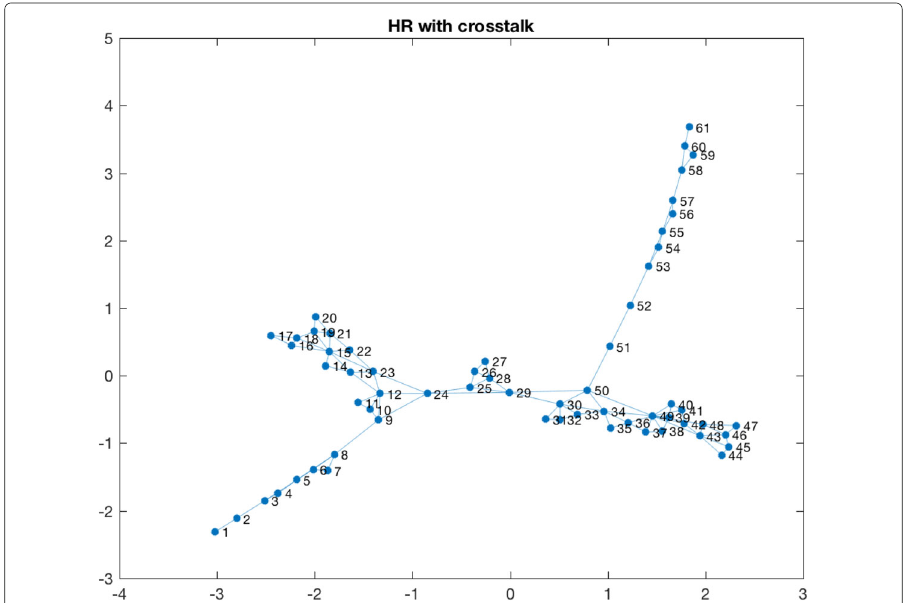
Fig. 4 HR graph with cross talk. The figure shows the HR horizontal visibility graph corresponding to the time window in which a cross talk is detected and shown in Fig.